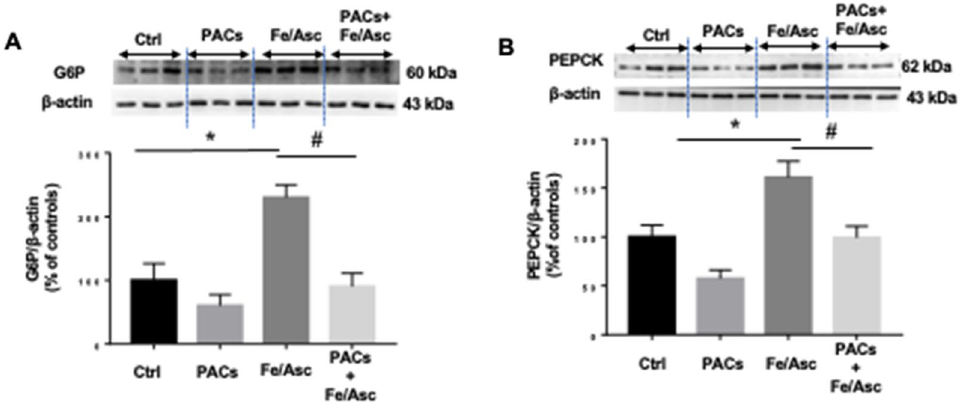
Figure 6. Effects of PACs on neoglucogenesis in Caco-2/15 cells. Proanthocyanidins (PACs, 250 µg/mL) were added to the apical cell compartment for 24 h prior to treatment with Fe/Asc (200 µM/2 mM) for 6 h at 37 °C. The protein expression of ( A ) G6Pase and ( B ) PEPCK was assessed by Western blot. Results represent the means ± SEM of 3 independent experiments, each in triplicate. A representative Western blot is shown, illustrating an experiment in triplicate on the same gel and at the same exposure. *P < 0.05 vs untreated cells (ctrl). # P < 0.05 vs Fe/Asc treated cells. G6Pase glucose-6-phosphatase, PEPCK phosphoenol pyruvate